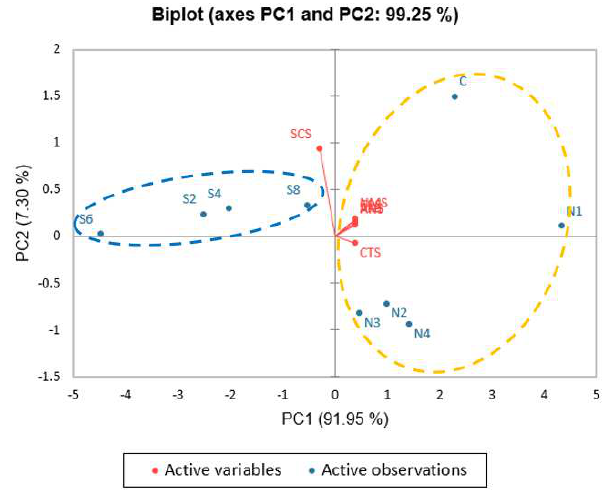
Figure 5. PCA biplot of E-tongue flavor attributes in control unseasoned soup, unseasoned soup with 0.2–0.8% SGM, and unseasoned-clear soups with varying NaCl concentrations. Red dots indicate E-tongue sensors. Differences among samples were identified using cluster analysis, and groups are represented by blue and yellow ovals ( p < 0.05). C: Control unseasoned soup sample, N1: 0.1% NaCl unseasoned-clear soup, N2: 0.2% NaCl unseasoned-clear soup, N3: 0.3% NaCl unseasoned-clear soup, and N4: 0.4% NaCl unseasoned-clear soup; S2: 0.2% SGM unseasoned soup, S4: 0.4% SGM unseasoned soup, S6: 0.6% SGM unseasoned soup, and S8: 0.8% SGM unseasoned soup.